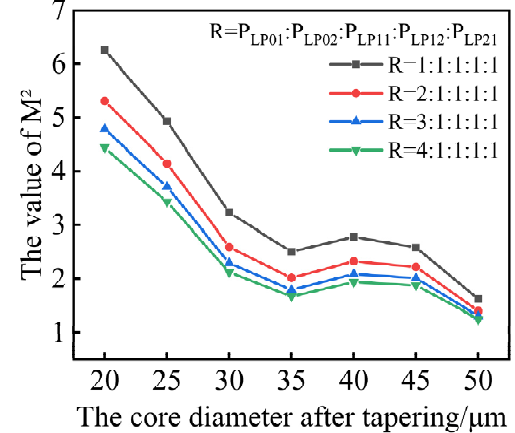
Figure 2. The output beam quality corresponds to different input mode ratio and different input fiber tapering degree. tapering